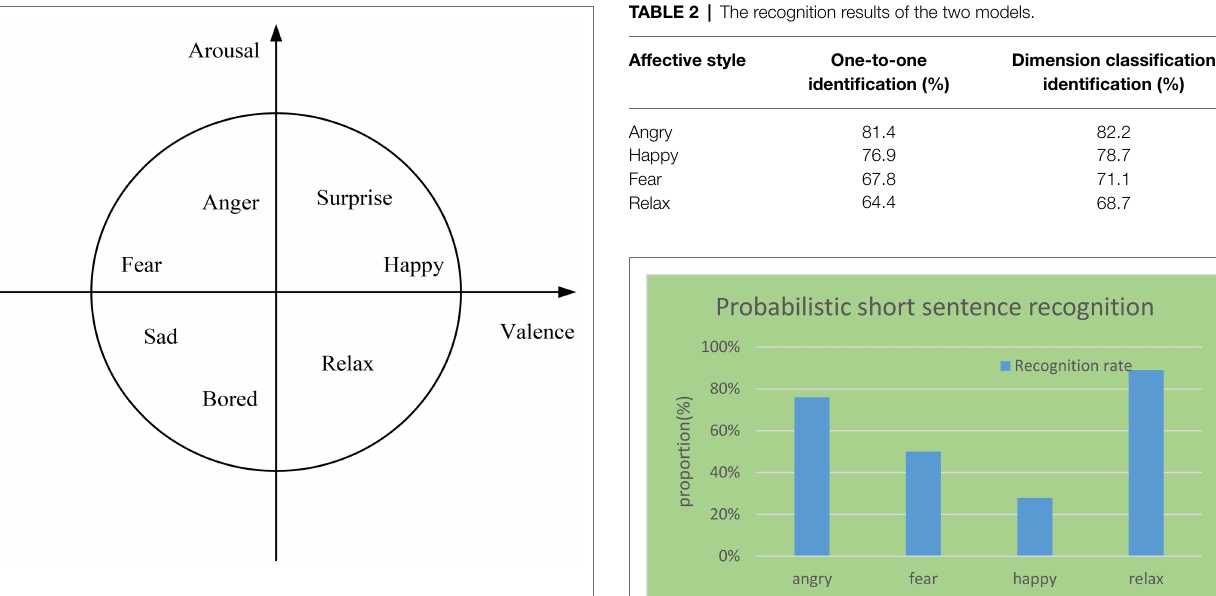
FIGURE 9 | Valence-Arousal coordinate system.